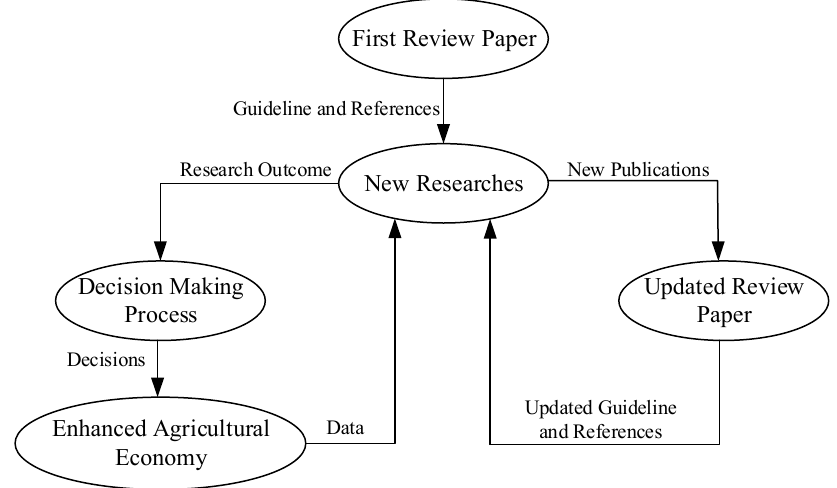
Figure 2. Virtuous cycle between review papers, new research and the decision-making process.